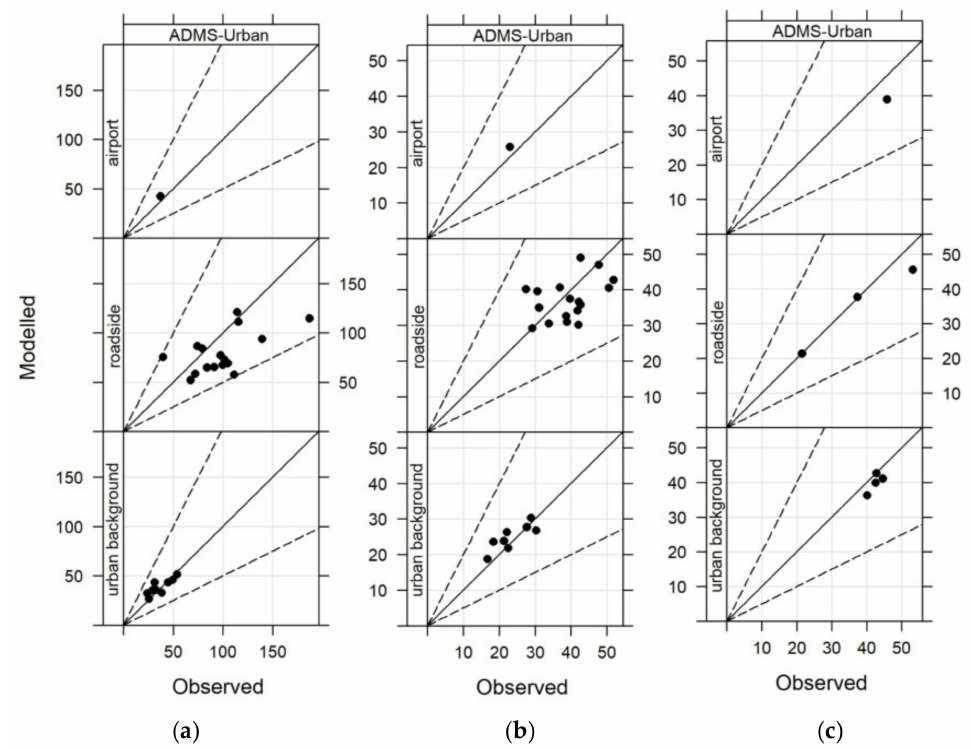
Figure 4. Comparison of annual averages between model output and measurement: ( a ) for NO x (in µ g m − 3 ), ( b ) for NO 2 (in µ g m − 3 ) and ( c ) for O 3 (in µ g m − 3